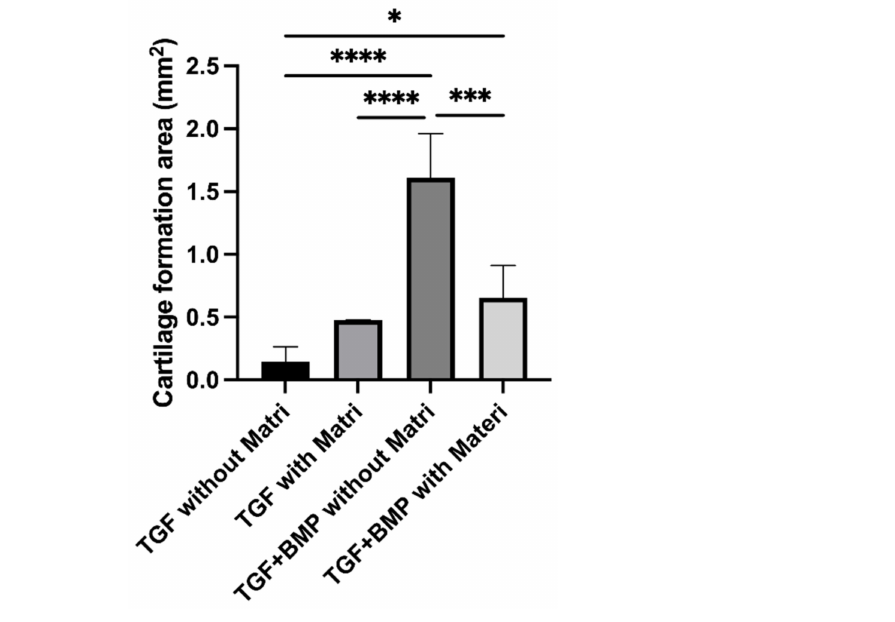
Figure 7. Quantitative analysis of cartilage formation area on the surface of 300TCP. Data are presented as the mean ± standard deviation (SD). One-way ANOVA was used to compare two variables with Tukey’s post hoc test. *: p < 0.05, ***: p < 0.0001, ****: p <